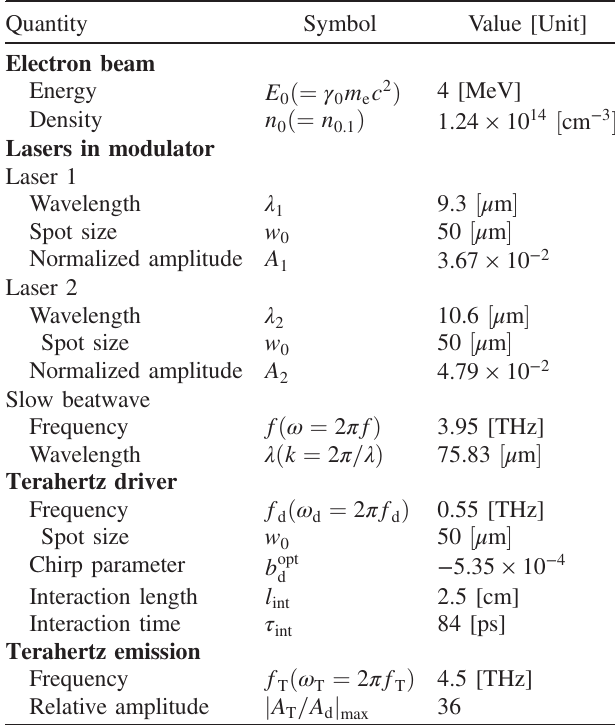
TABLE I. All parameters and their values for the numerical calculation.